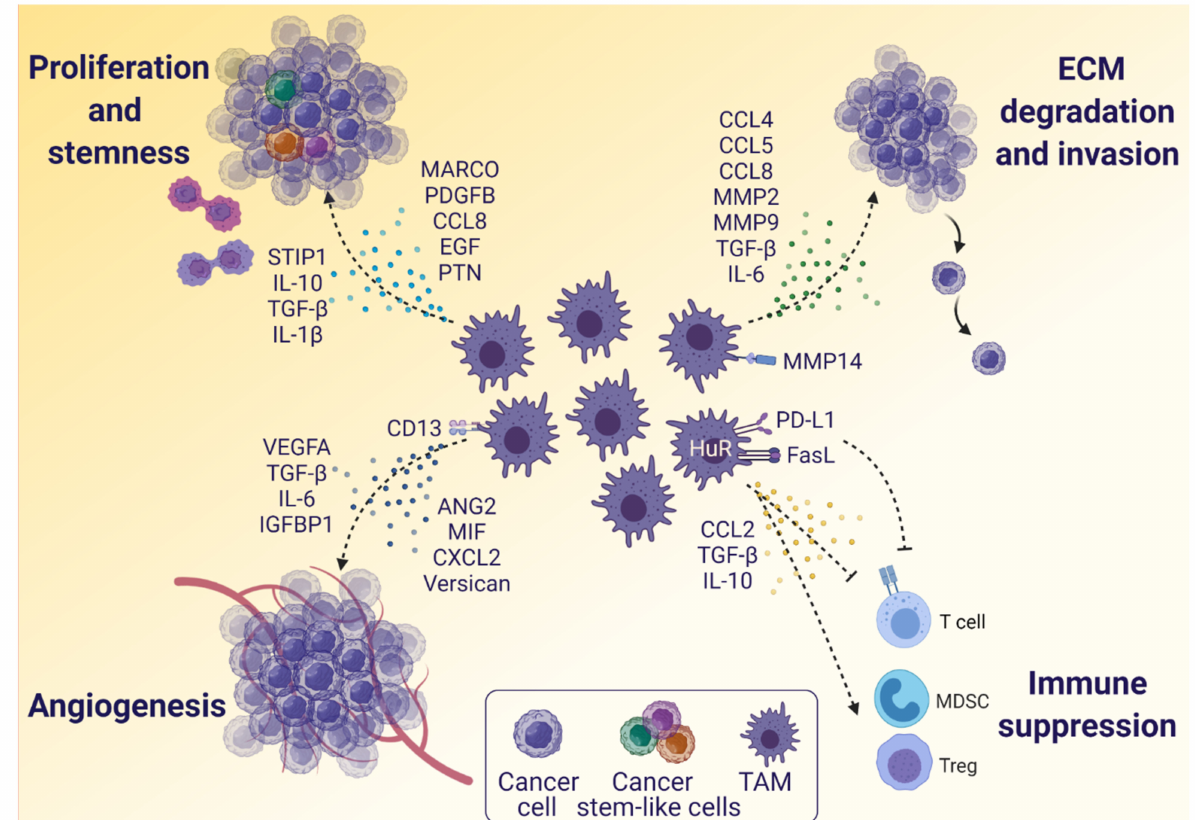
Figure 3. The influence of TAMs on glioblastoma cells. TAMs express many factors that promote major biological functions in tumor progression. Glioblastoma proliferation and stemness are highly affected by TAM-secreted factors, such as cytokines and growth factors. Angiogenesis, the essential process of neovascularization in glioblastoma tumors, is also promoted by several TAM-derived factors, including VEGF and VEGF-inducing factors, but also VEGF-independent pathways. Additionally, glioblastoma invasion is promoted by TAM-produced MMPs and cytokines inducing extracellular matrix (ECM) degradation and facilitating migration. Moreover, TAMs express factors to suppress anti-tumor immune responses. Pro-inflammatory cytotoxic T cells and helper T cells are inhibited, while anti-inflammatory myeloid-derived suppressor cells (MDSCs) and regulatory T cells (Tregs) are attracted to the tumor, where they facilitate tumor immune evasion. Abbreviations: stress-induced phosphoprotein 1 (STIP1), macrophage receptor with collagenous structure (MARCO), platelet derived growth factor B (PDGFB), epidermal growth factor (EGF), pleiotrophin (PTN), insulin-like growth factor- binding protein 1 (IGFBP1), angiopoietin (ANG2), macrophage migration inhibitory factor (MIF), Fas ligand (FasL). Created with BioRender.com (accessed on 16 August